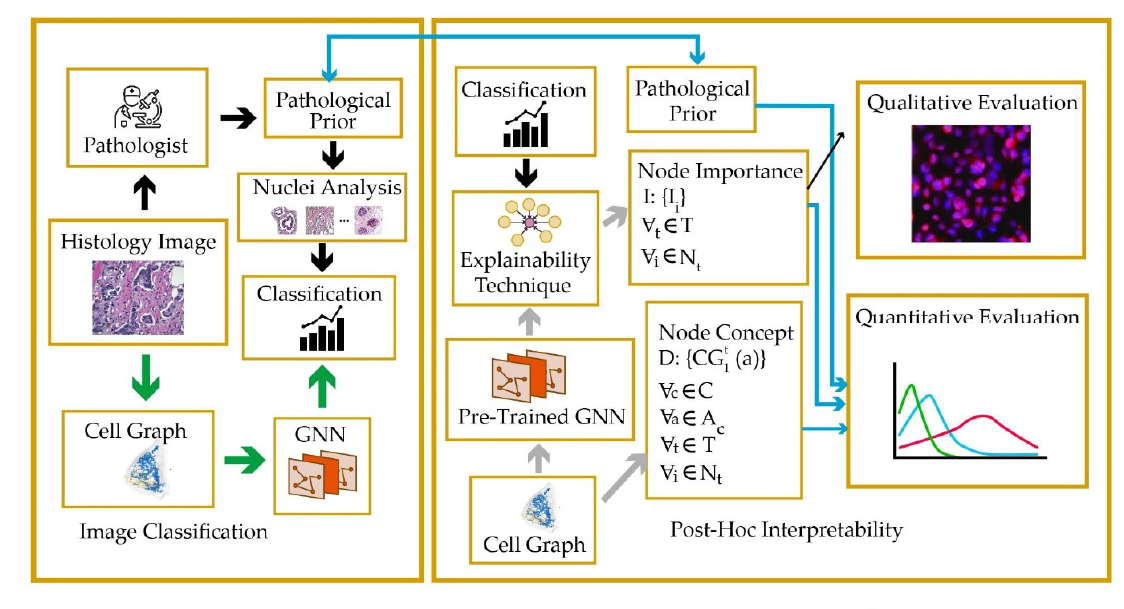
Figure 8. Proposed model based on graph breast cancer identification.